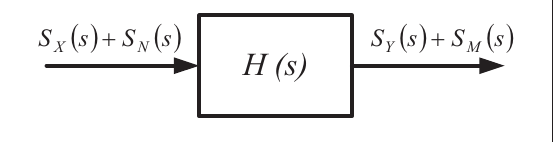
Figure 2. Spectral density of signals and noise at the input and output of the control system